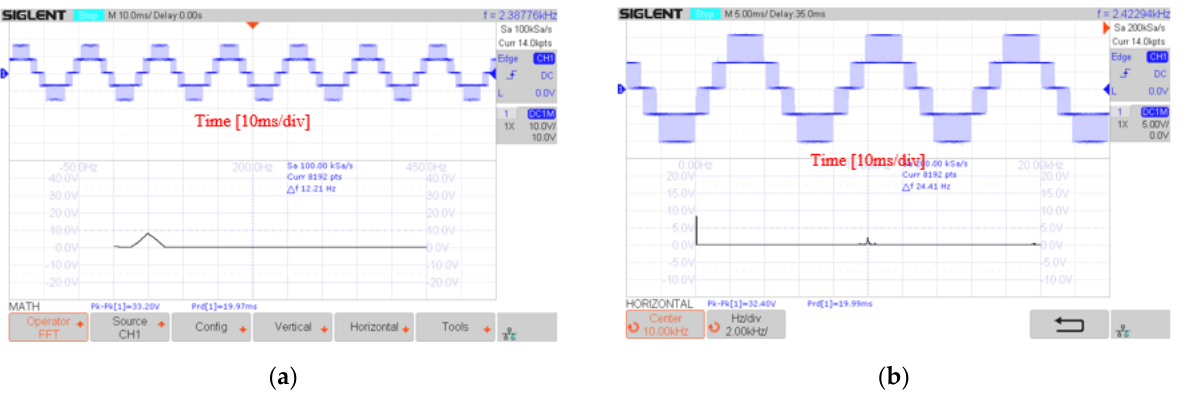
Figure 46. FFT analysis of output voltage, ( a ) spectrum of nine first harmonics; ( b ) spectrum of 400